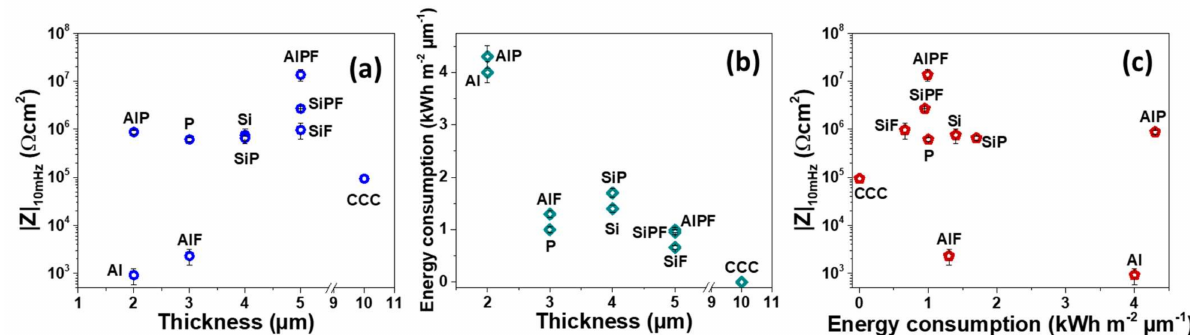
Figure 2. ( a ) Plot summarizing the values of total impedance modulus obtained from the Bode plots from CCC reference sample and studies PEO coatings following 15 min immersion in 0.5% NaCl in relation to the layer thickness. ( b ) Summary of the FPEO processes’ energy consumption calculated per 1 µ m of obtained coating thickness in relation to final thickness of the layers. ( c ) Comparison of energy consumption vs. the final coatings’